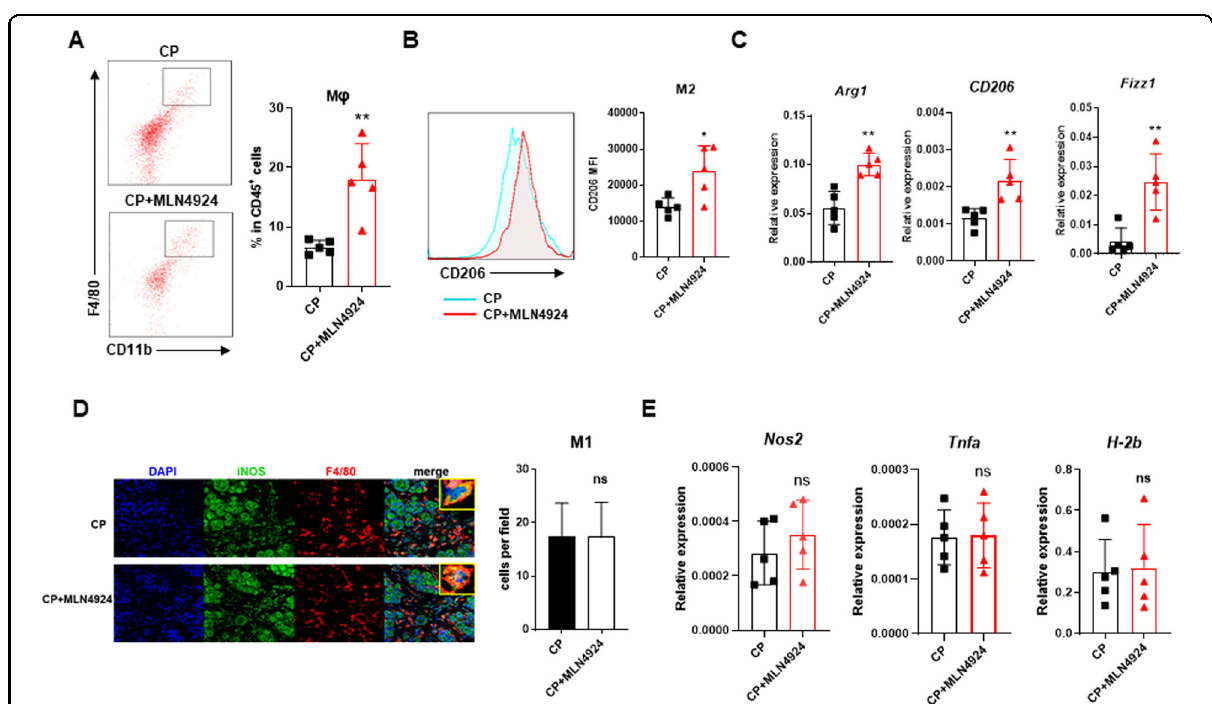
Fig. 2 Neddylation inactivation contributes to elevated M2 macrophage in fi ltration. A Representative fl ow cytometric fi gures and percentages of macrophages in pancreata from different groups of mice. B Representative fl ow cytometric fi gure and mean fl uorescence intensity of CD206 in pancreatic macrophages. C mRNA expression of M2-associated genes Arg1 , Fizz1 and CD206. D Representative immuno fl uorescence images of pancreata, co-stained with F4/80, iNOS and DAPI. E mRNA expression of Nos2, Tnfa , and H-2b in pancreata. A – E n = 5. Data are representative of three independent experiments. *p < 0.05, ** p < 0.01, *** p < 0.001, ns no signi fi cant, MFI mean fl uorescence